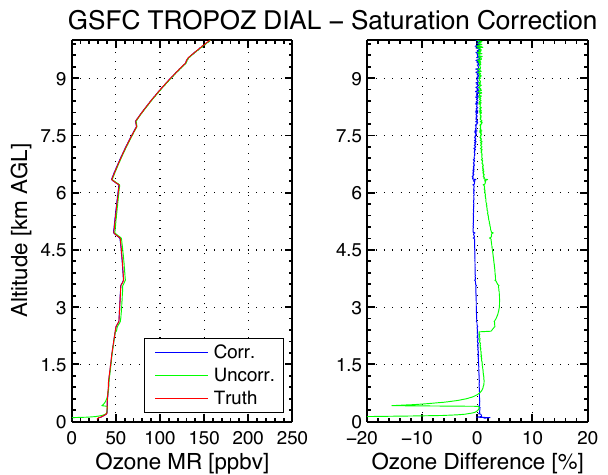
Figure 6. The left panel shows the retrieved ozone mixing ratios from the TROPOZ opt ozone profiles as compared to the known ozone profile used in the simulated lidar return signal without the addition of statistical noise. The right panel shows the percent dif- ference from the known profile and retrieved